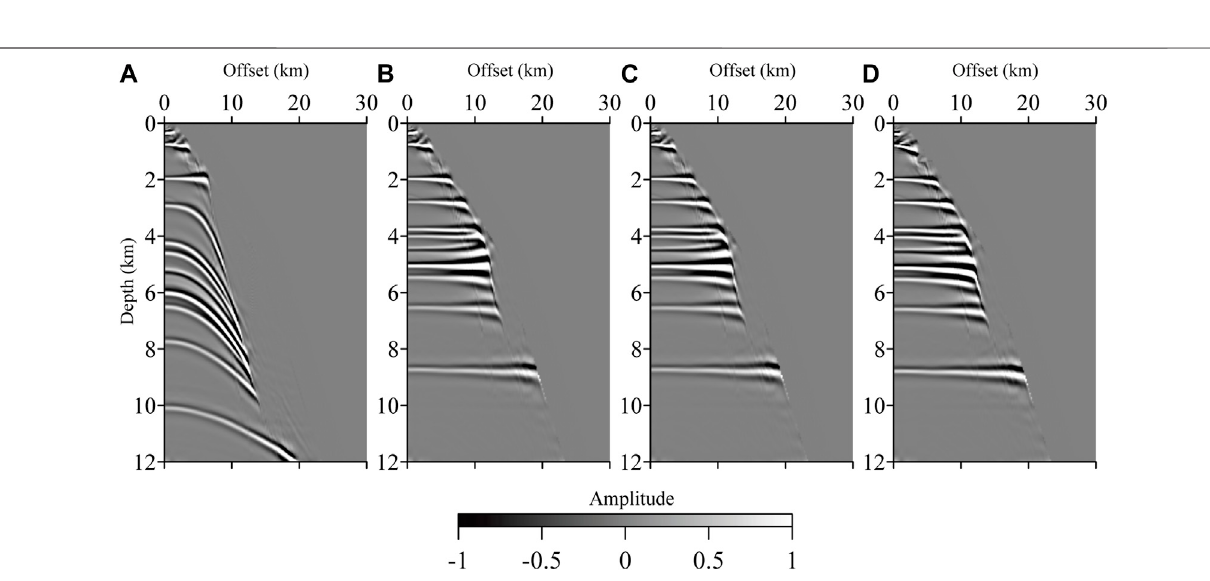
Frontiers in Earth Science |